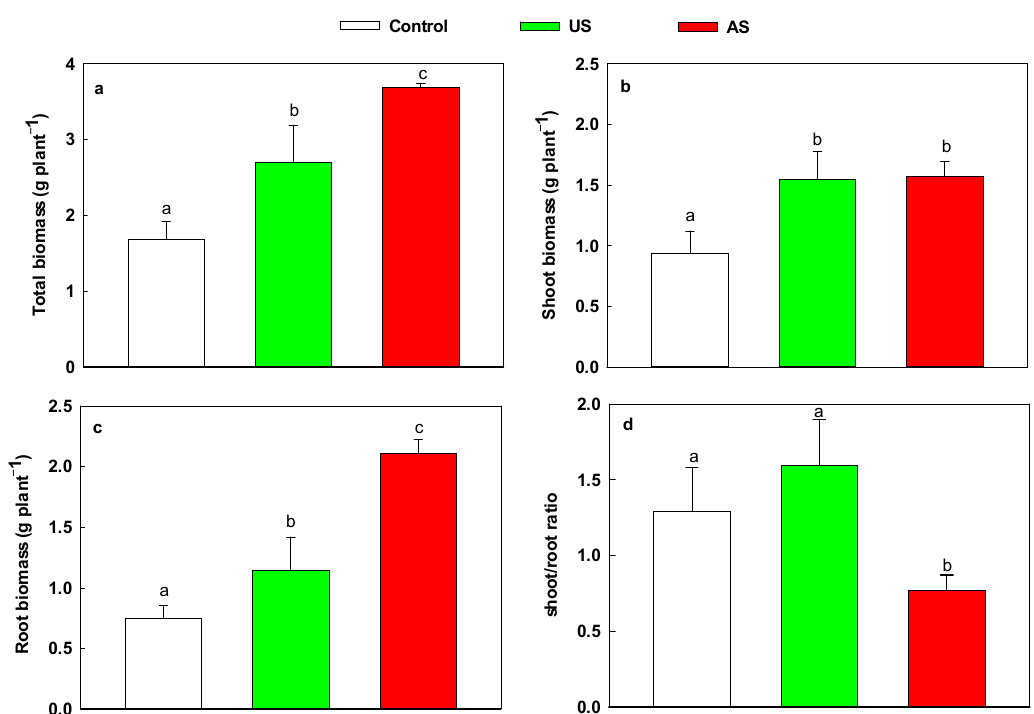
Figure 4. Total biomass ( a ), shoot biomass ( b ), root biomass ( c ), and shoot/root ratio ( d ) of plants fertilized with commercial nutrition solution (control) and in plants fertilized with untreated (US) and pre-treated (AS) slurry. Data are means ( n = 5) ± SE. Different letters denote statistically significant differences among treatments. p < 0.05.